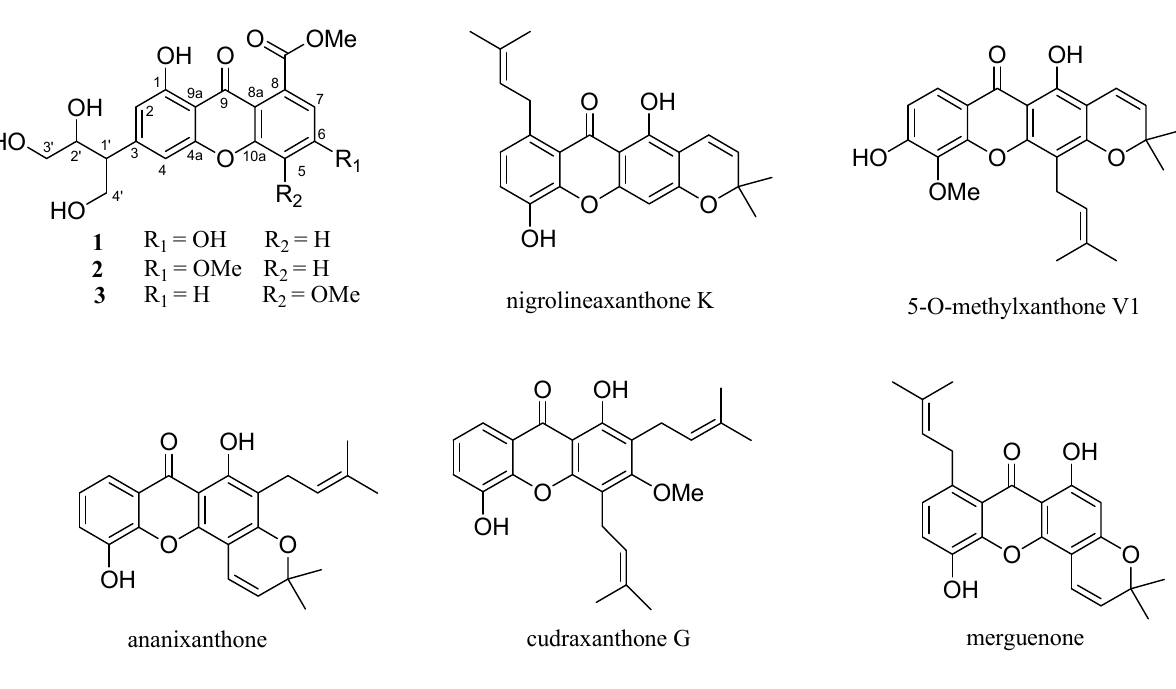
Figure 1. The structures of compounds 1 – 8